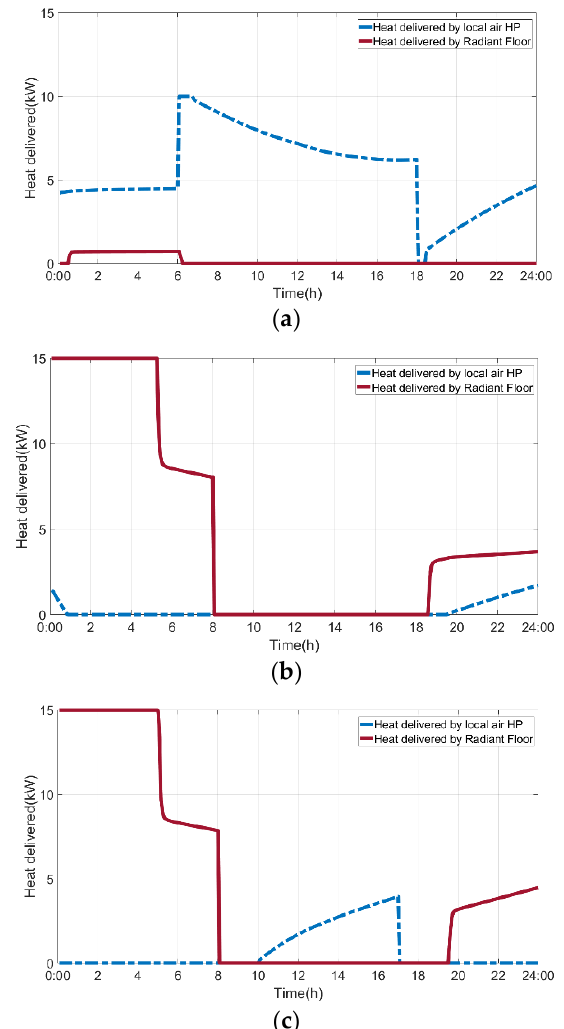
Figure 16. Heat delivered to the thermal zones in different control strategies: ( a ) Control Strategy 1 (reference case); ( b ) Control Strategy 2; ( c ) Control Strategy 3.